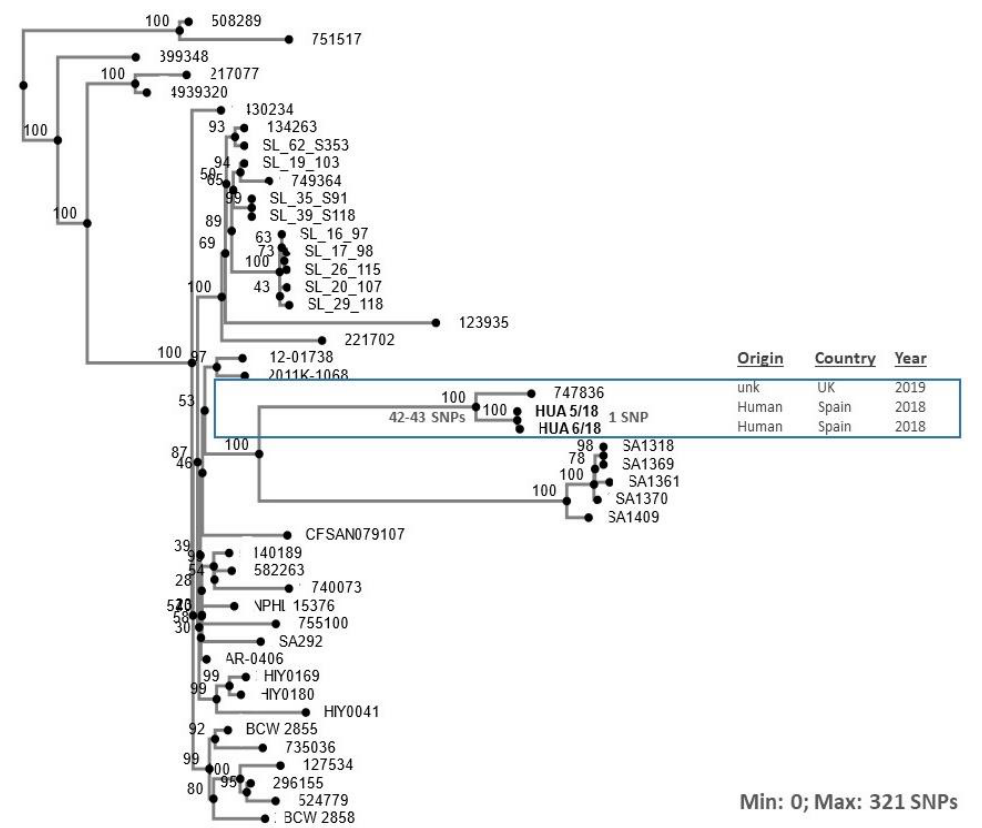
Figure 2. Phylogenetic tree showing the relationships between Salmonella enterica serovar Corvallis ST1541 isolates from a Spanish hospital and other S . Corvallis ST1541 isolates from different countries and sources (Table S1). The minimum and maximum numbers of SNPs are indicated (see Table S2). The branch containing the Spanish isolates (highlighted in bold) is enclosed in a rectangle, which includes information available for the isolates shown at the right of the figure (unk = unknown). The tree was constructed with the CSI Phylogeny, based on single nucleotide polymorphisms identified by using the genome of S . Corvallis HUA 6/18 as reference. Numbers at the nodes represent bootstrap values resulting from 1000 replicates.